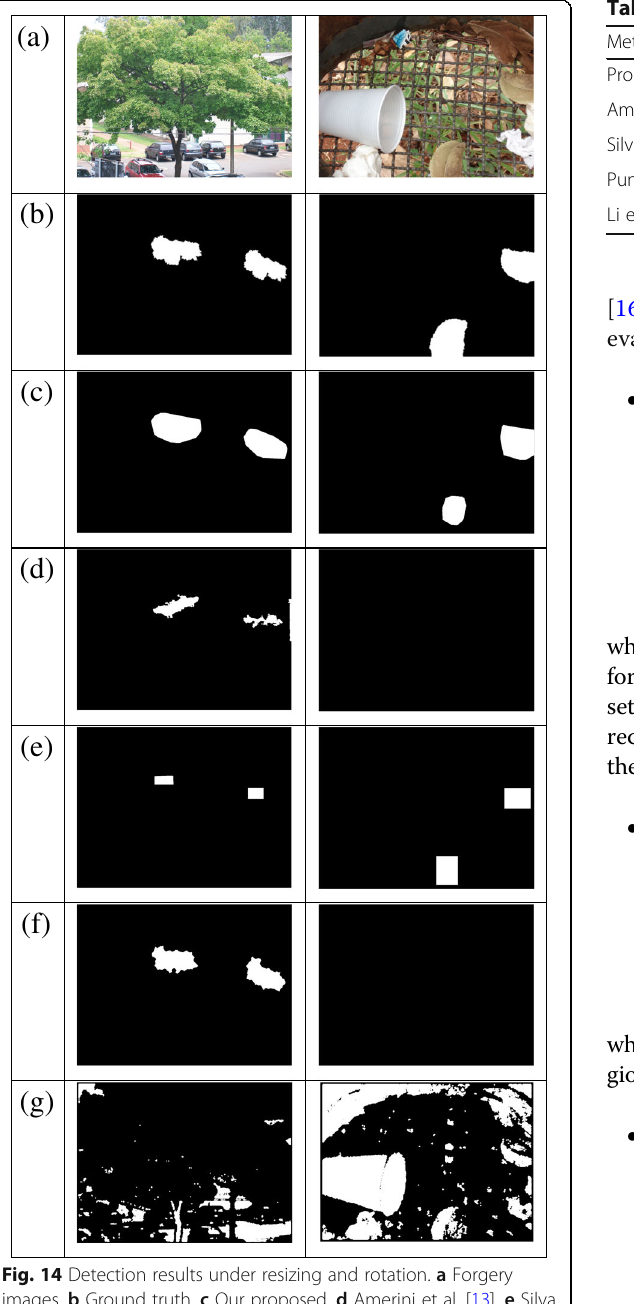
color. And the tampered region within the datasets is of a single region copied one time and stayed in the same image.